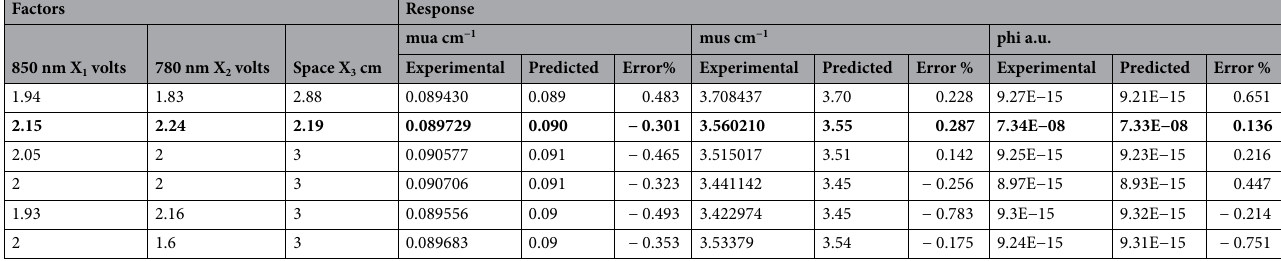
Table 6. Optimization Process for mua, mus, phi-RSM versus Experimental. Significant values are in bold.